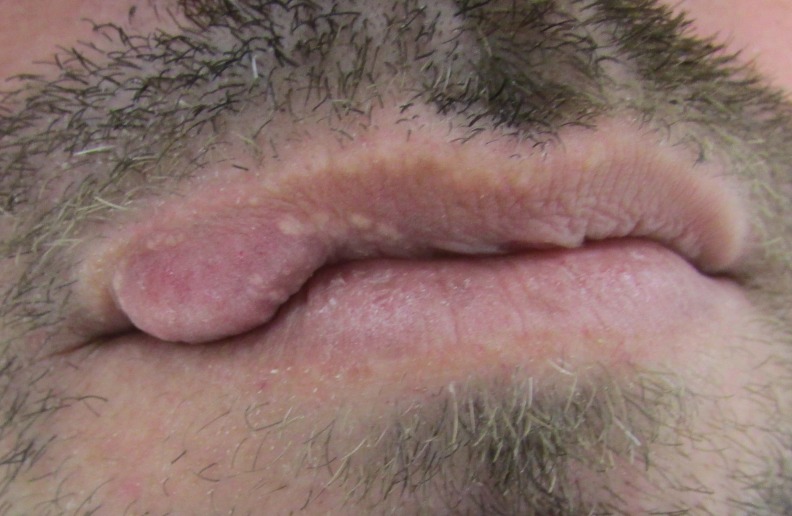
Clinical appearance: nodular lesion on upper lip.